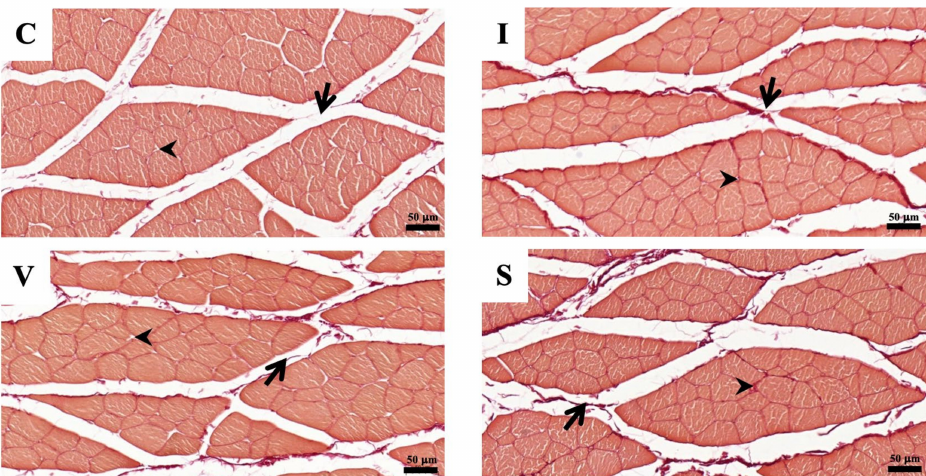
Figure 6. The photomicrographs of Picrosirius red staining of quadriceps muscle cross-sections under a light microscope, in Group C ( C ), Group I ( I ), Group V ( V ), and Group S ( S ) on Day 15. ( C ) Control group; ( I ) Cast immobilization group; ( V ) Velcro immobilization group; ( S ) Spiral wire immobilization group. Dark-red-stained color is collagen, while orange to light-red-counterstained color is muscle fiber. Arrows indicate perimysium, arrowheads indicate endomysium. Magnification at ×